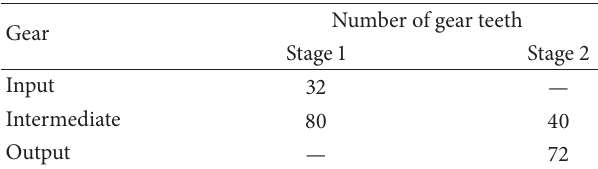
Table 1: Fixed-shaft gearbox